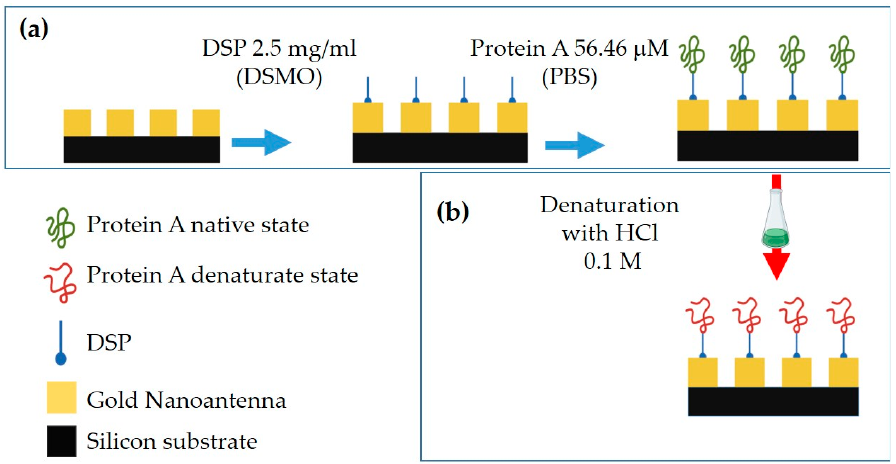
Figure 4. Schematic of PA binding on gold Nas and of denaturation process: ( a ) Binding of PA on gold surface by using DSP molecule; ( b ) PA denaturation process by incubation in HCl 0.1 M.